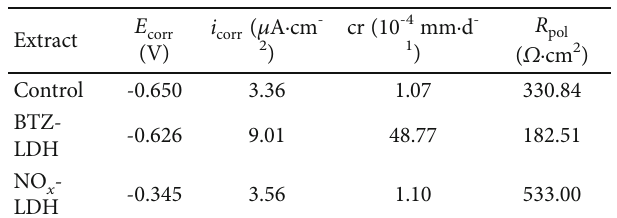
Figure 10: OCP pro fi les obtained for extract form LDH systems. Table 5: Electrochemical parameters obtained from polarization curves for carbon steel